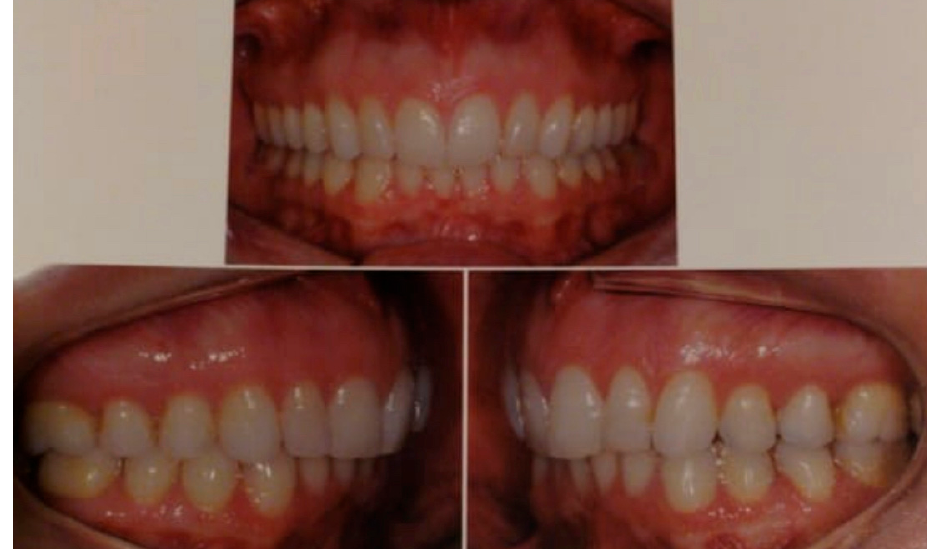
Figure 1. Preoperatory status of the occlusion. Orthognathic surgery was indicated to reduce the overjet and perceived discrepancy on the right side.